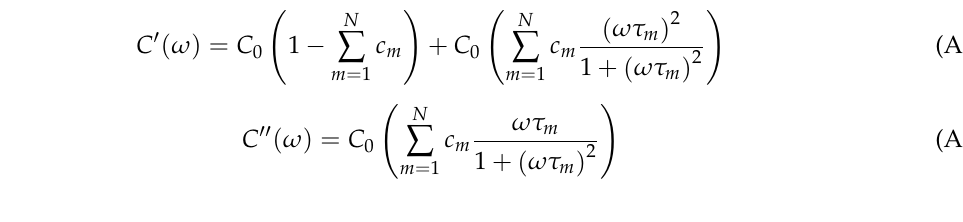
Table A1. Elastic material parameters of